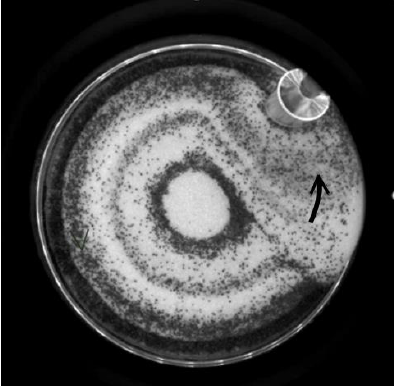
Fig. 2: Typical picture of the free-surface after 15 turns with large particles (appearing black) that have segregated , and small particles appearing in white. Initially the top surface was only covered with small white particles.